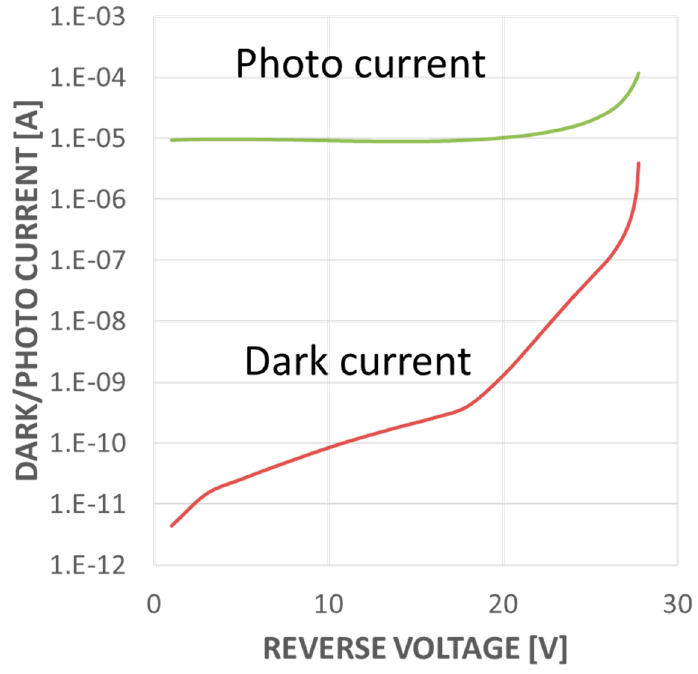
Figure 7. Responsivity of the surface-illuminated InAs quantum dots (QDs) and InGaAs [12].